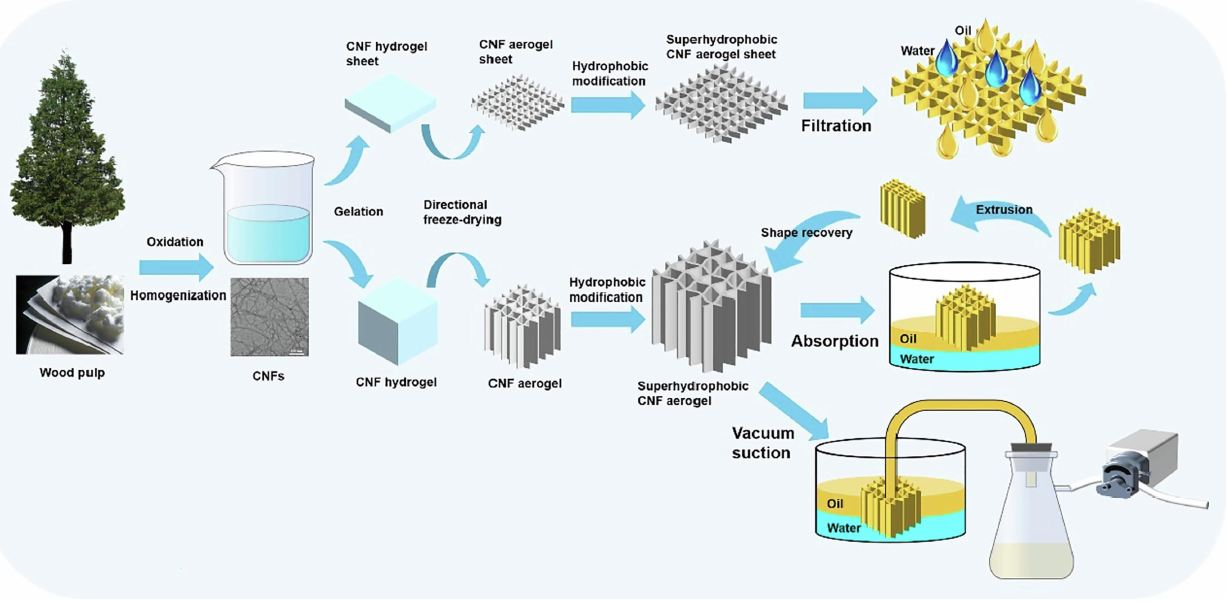
Figure 9. Preparation and oil-water separation diagrams of CNF-PDMS aerogel sheets and blocks [152] .